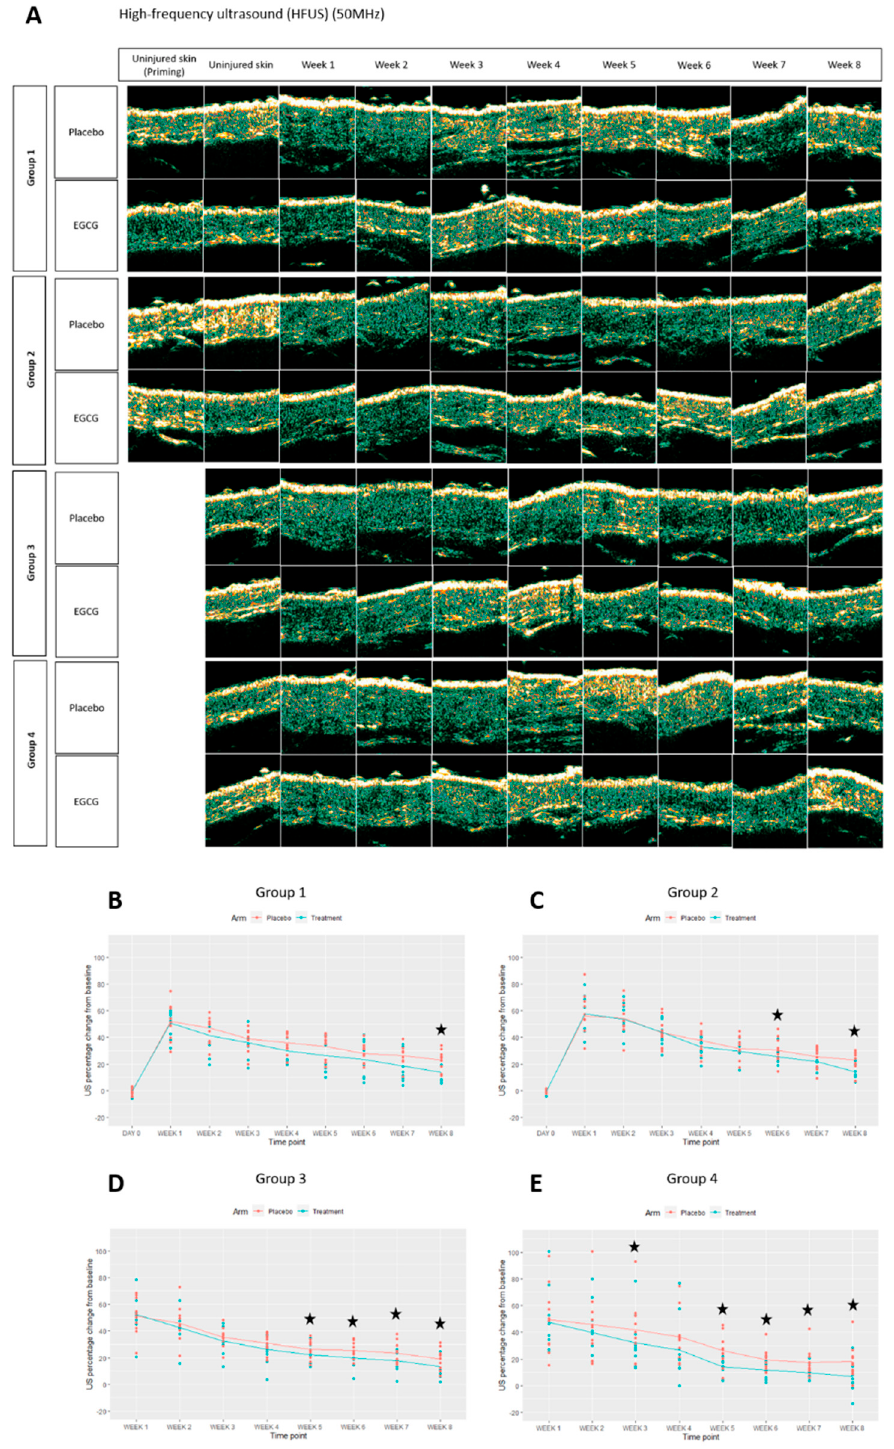
Figure 21. Skin thickness analysis (High frequency ultrasound (HFUS)) of topical epigallocatechin-3-gallate (EGCG) versus placebo. ( A ) Images of skin/scar thickness using high frequency ultrasound (HFUS). ( B ) Group 1 skin thickness HFUS. ( C ) Group 2 skin thickness HFUS. ( D ) Group 3 skin thickness HFUS. ( E ) Group 4 skin thickness HFUS. Significance: ★ p ≤ 0.01. Error bars: mean ± SD. Scale bars = 100 μ m.